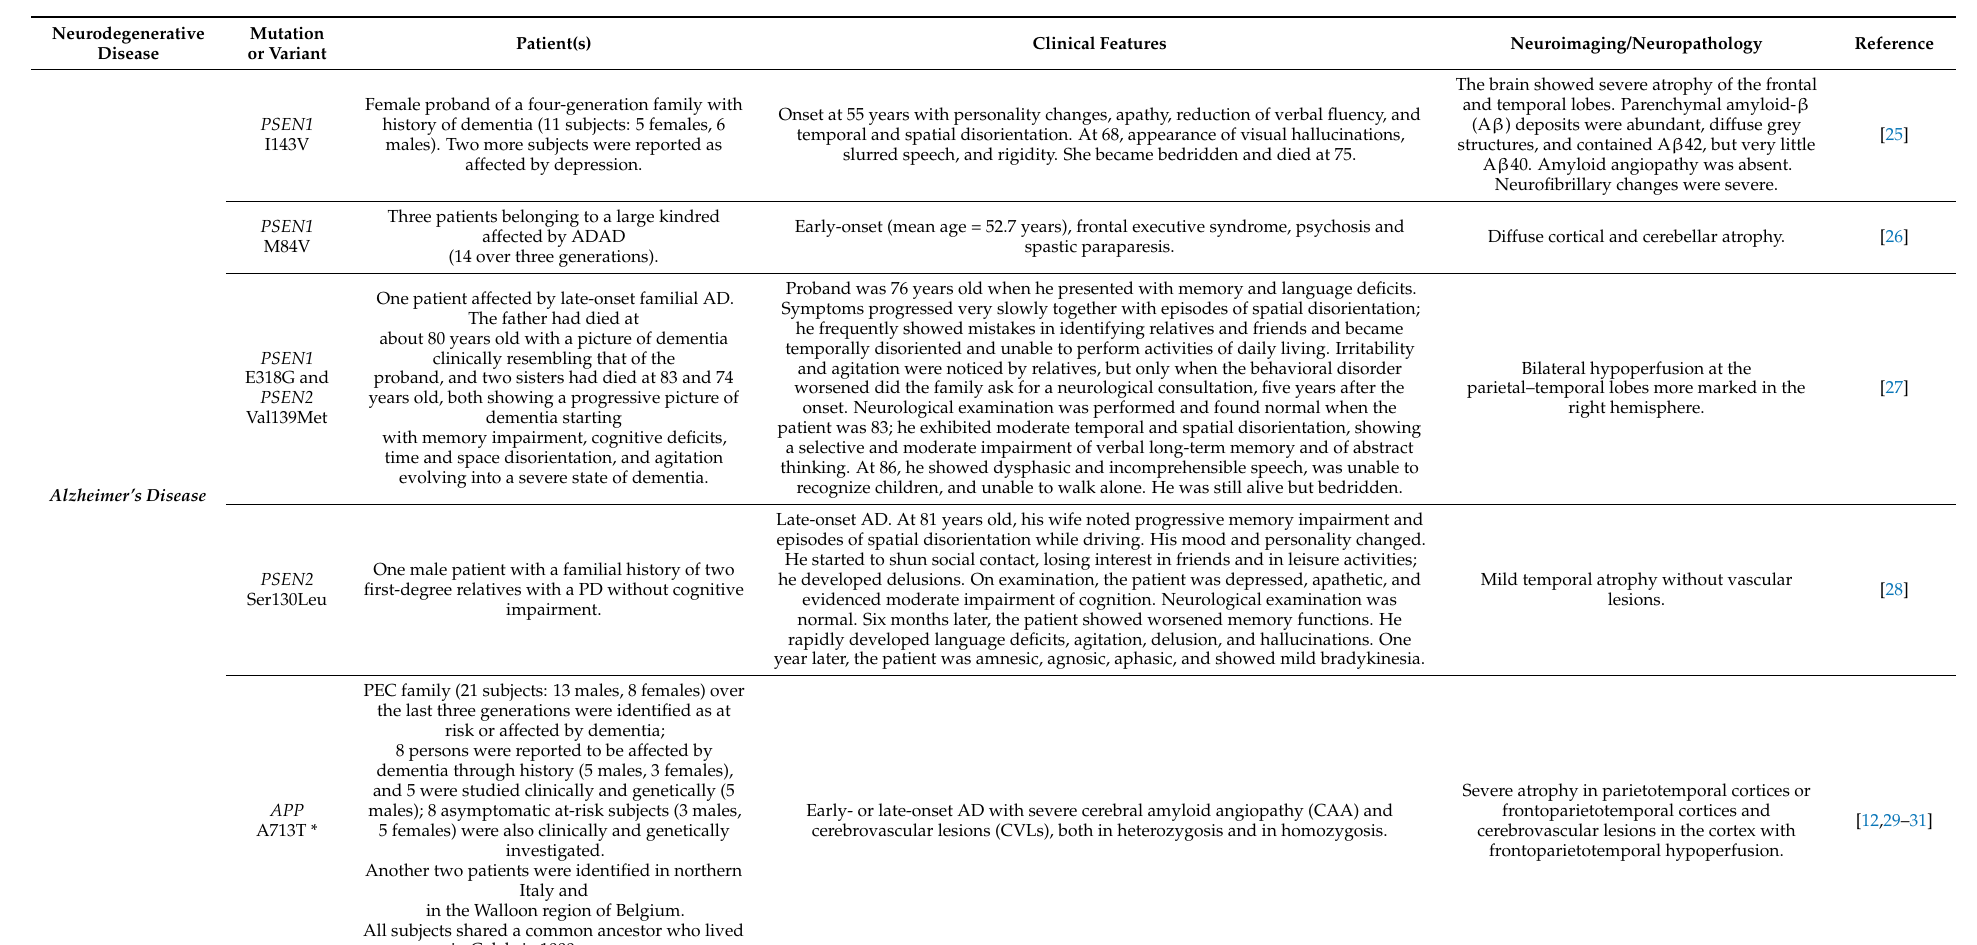
Table 1. Novel mutations or variants associated with neurodegenerative diseases in Calabrian